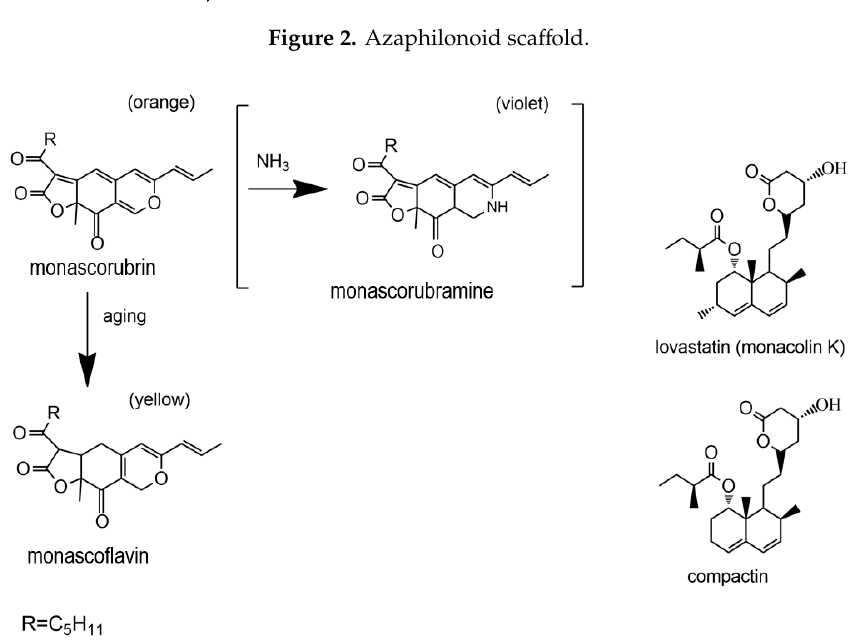
Figure 3. Azaphilone pigments derived from the yeast Monascus .